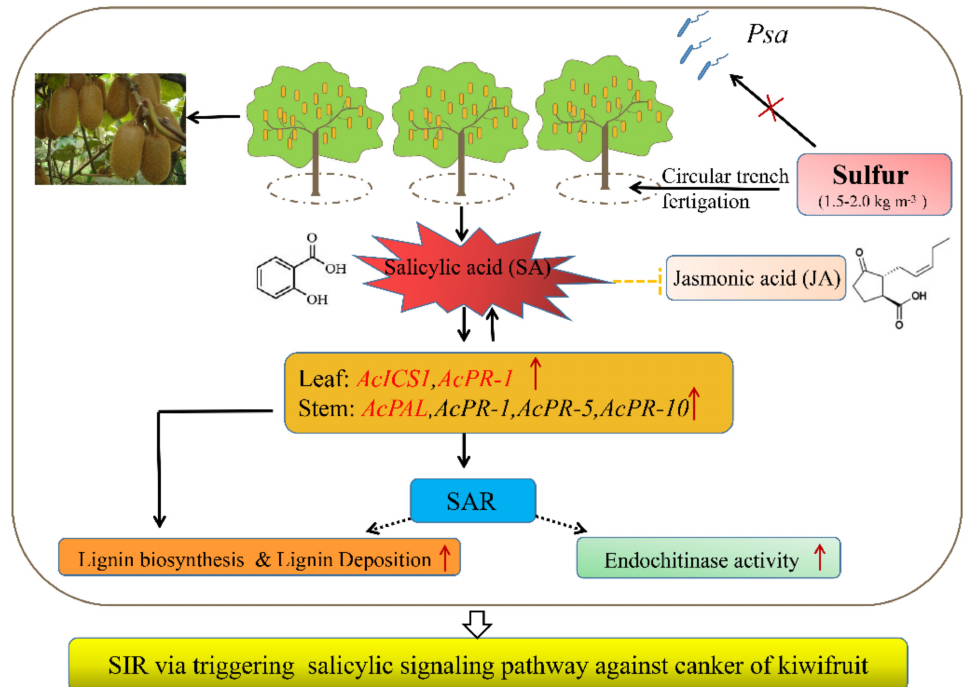
Figure 9. A proposed model describing how sulfur mediates salicylic acid and its pathway to regulate kiwifruit canker resistance was proposed. PR- 1 and ICS1 genes are involved in the activation of signals on SA and then activates systemic acquired resistance (SAR), contributing to the resistance of kiwifruit to Pseudomonas syringae pv. actinidiae